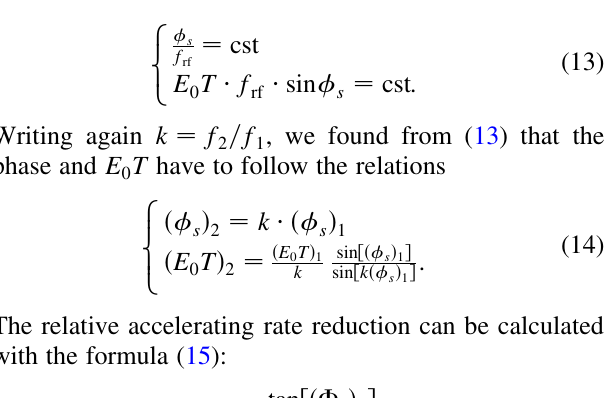
FIG. 1. (Color) The relative accelerating rate reduction with respect to the synchronous phase of the low frequency section when k (cid:4) 2 .